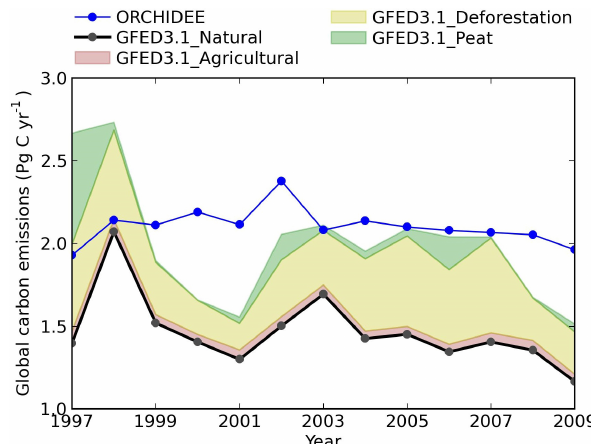
Figure 3. Annual global fire carbon emissions for 1997–2009 sim- ulated by ORCHIDEE (blue), and from the GFED3.1 data. Car- bon emissions from natural sources (forest fire, grassland fire, and woodland fire) are shown as the black solid line. Carbon emissions from agricultural fire, deforestation fire and peat fire (which are not explicitly simulated in ORCHIDEE) are shown as shaded areas stacked on top of GFED3.1 natural source fire carbon